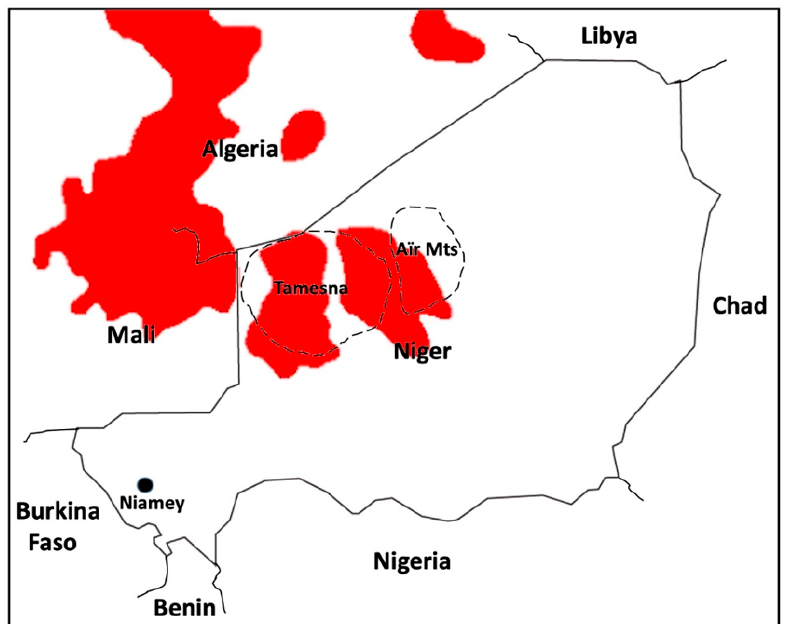
Figure 11. Locations and regions mentioned in the text in relation to desert locust activity and insecurity in Niger. Primary breeding areas in red.